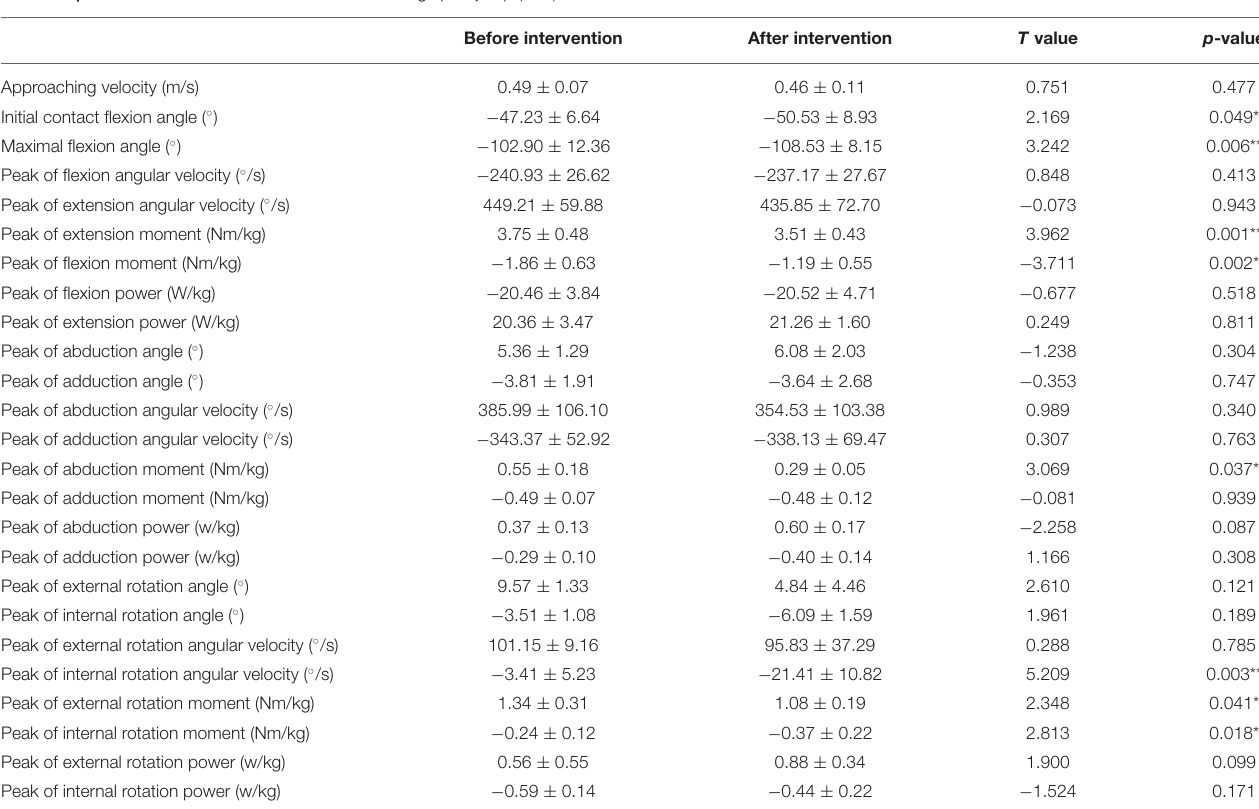
TABLE 2 | The biomechanics of knee movements during spike jump (SPJ). Before intervention After